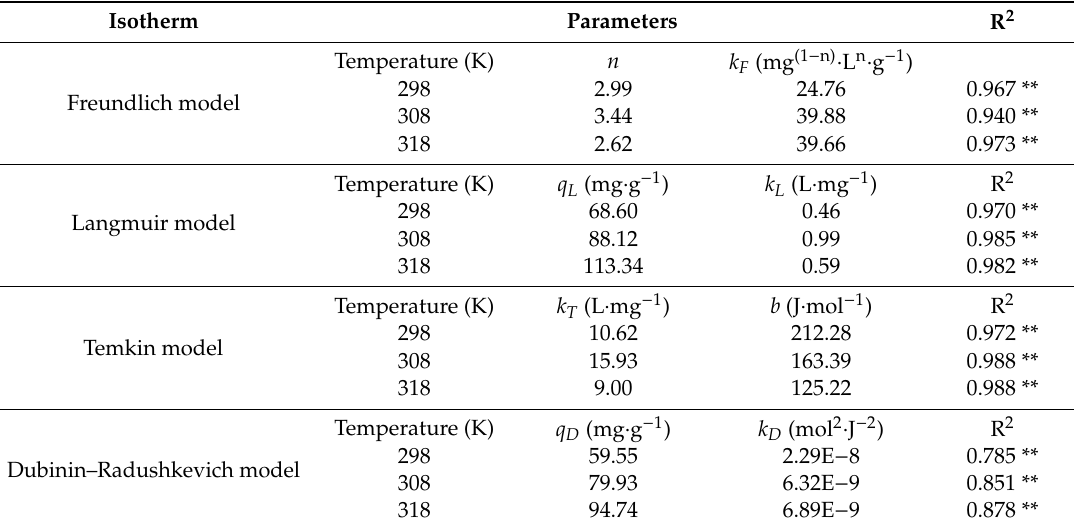
Table 4. Parameters of adsorption isotherm models for U(VI) adsorption onto HA.